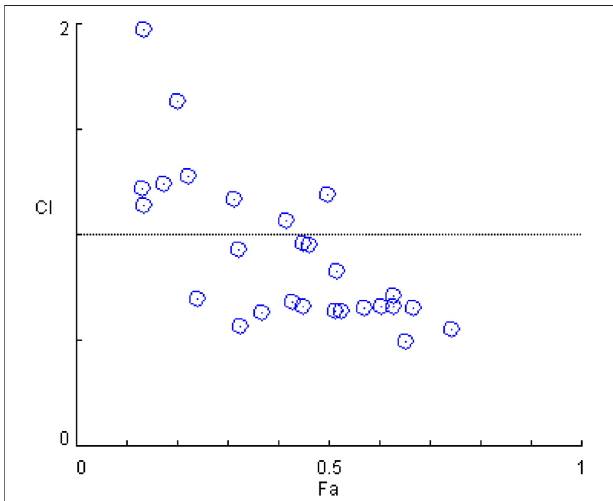
FIGURE 3 | Combination index analysis of the silibinin and capsaicin combination.